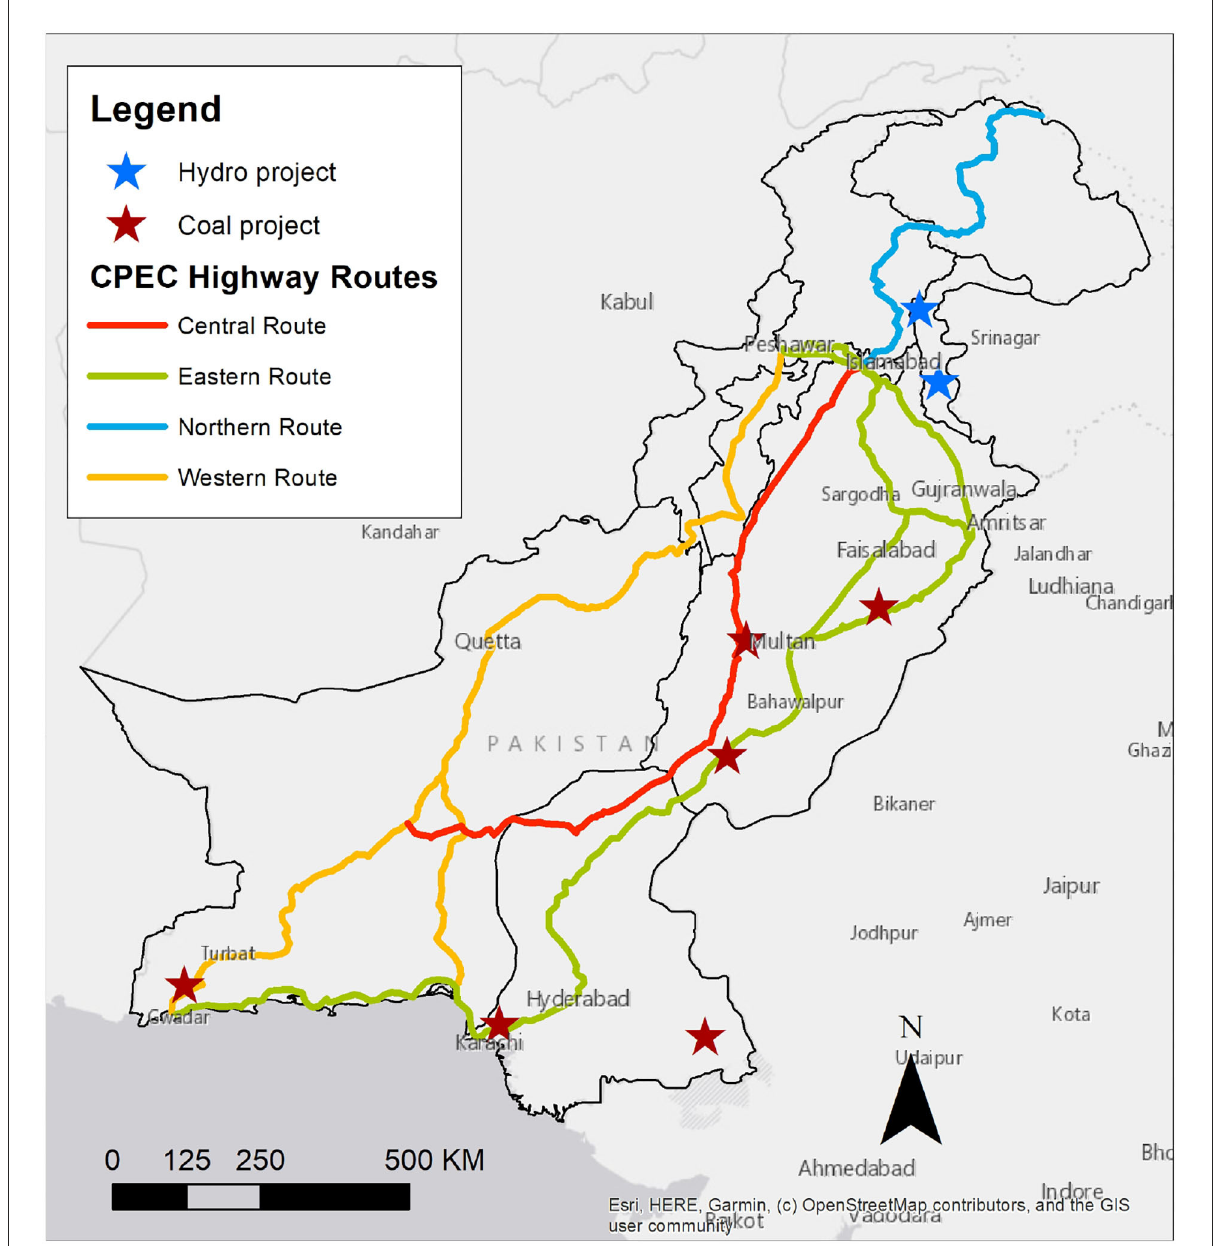
FIGURE1 Map of the China-Pakistan Economic Corridor (CPEC). Adapted from Farooqui and Aftab (2018) The CPEC is one of six economic corridors of the Belt and Road Initiative (BRI) initiative, which is located in the Indus River Basin between latitudes 23 ◦ 13 ′ N and 40 ◦ 18 ′ N and longitudes 60 ◦ 00 ′ E and 79 ◦ 57 ′ E, linking the city of Gwadar in southwestern Pakistan to China’s northwestern Kashgar of the autonomous region of Xinjiang via a vast network of highways and